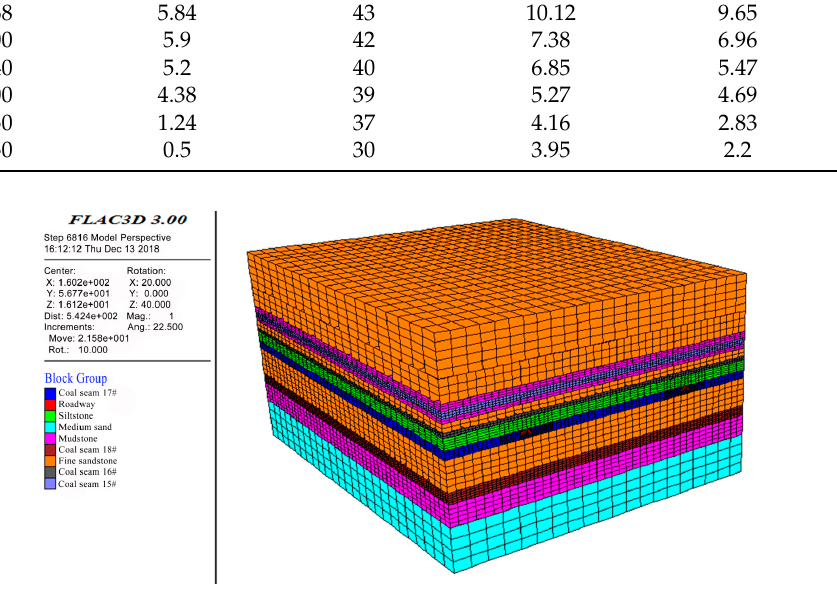
Figure 13. Numerical simulation model.